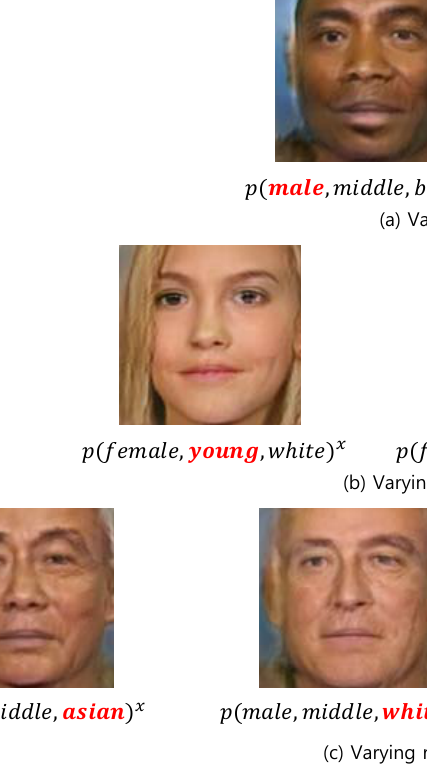
Figure 3. The results of our model: varying values of three group